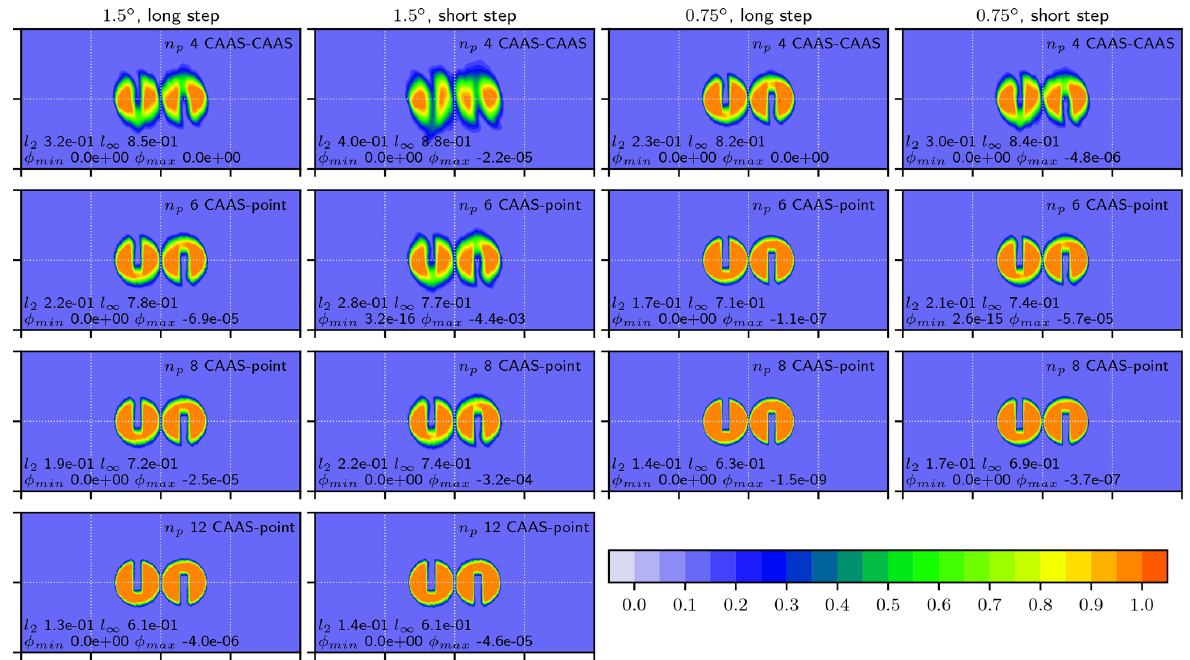
Figure 14. Same as Fig. 13 but for the simulation final point. Error measures are printed at the bottom left of each image; see text for details.